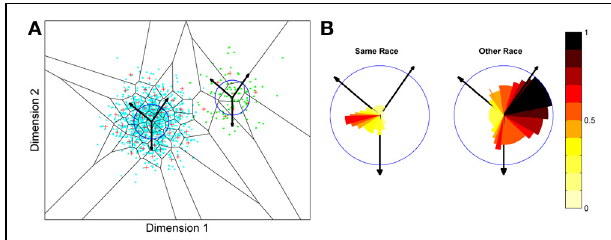
FIGURE 5 | Measuring face discrimination ability of the network. (A) The original face space with distributions corresponding to same and other-race faces (in light blue and green dots, respectively). The circles represent 1 s.d. from the center of each of the two distributions of faces. The arrows represent three example trajectories from the mean along which discrimination performance was measured. (B) Distractor rejection ability of the network measured as the number of steps taken (in 0.1 s.d. steps) before the network was able to discriminate the new face from the mean face image. The small amplitude of the cut-off for same race faces across all trajectory orientations is indicative of better discrimination performance by the network in the region corresponding to the same race